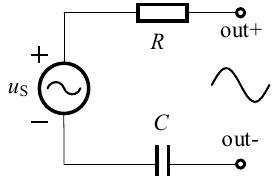
Figure 9. Lumped port external circuit.